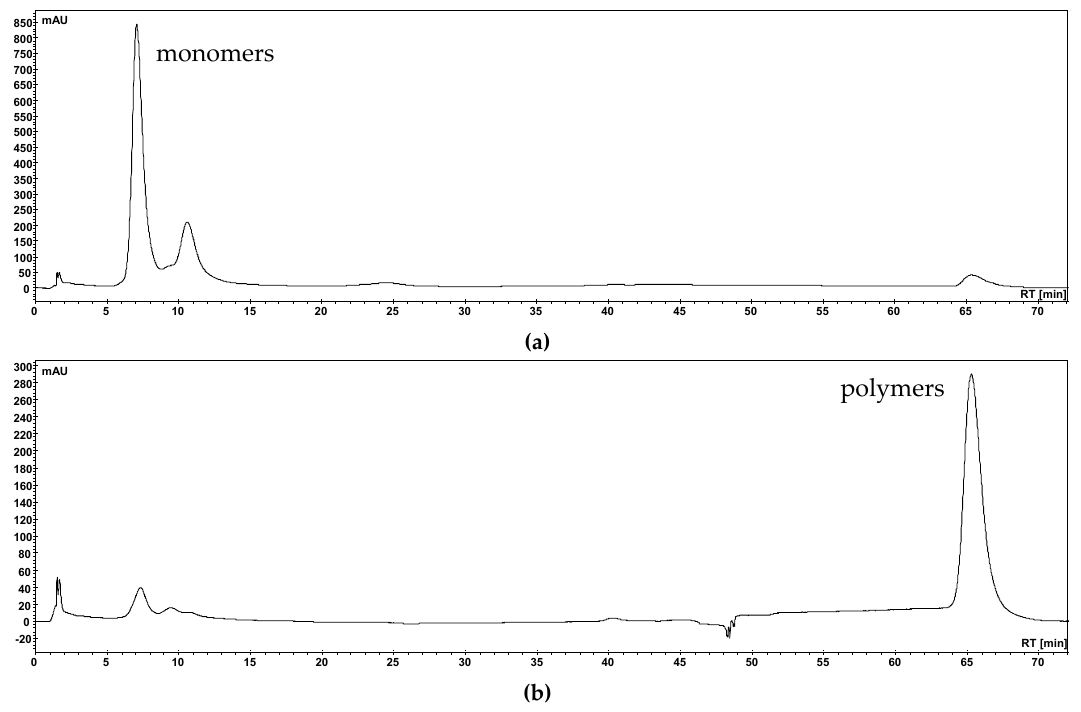
Figure 2. HPLC-PDA chromatograms after polymer precipitation with hexane at a wavelength of λ 280 nm of aronia NFC filtrate ( a ) and precipitate ( b ).